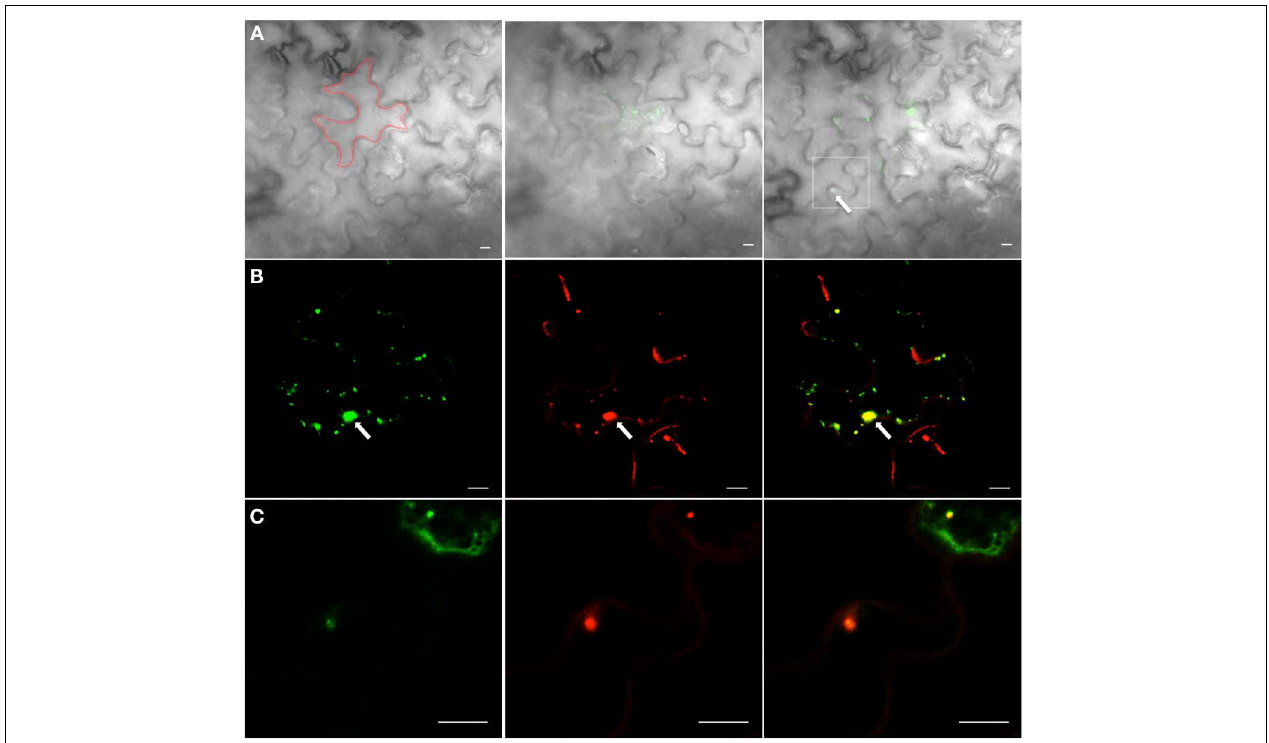
FIGURE 6 | 6K 2 -induced vesicles that have moved intercellularly contain RdRp. (A) Cells infected with TuMV expressing RdRp:DsRed and 6K 2 :PAGFP before activation (left panel), at activation (middle panel), and 2h after activation (right panel). Only the green signal is shown. The bright field indicates cell borders; Red line indicates activation area; white square denotes the presence of an activated 6K2:PAGFP vesicle in adjoining cell